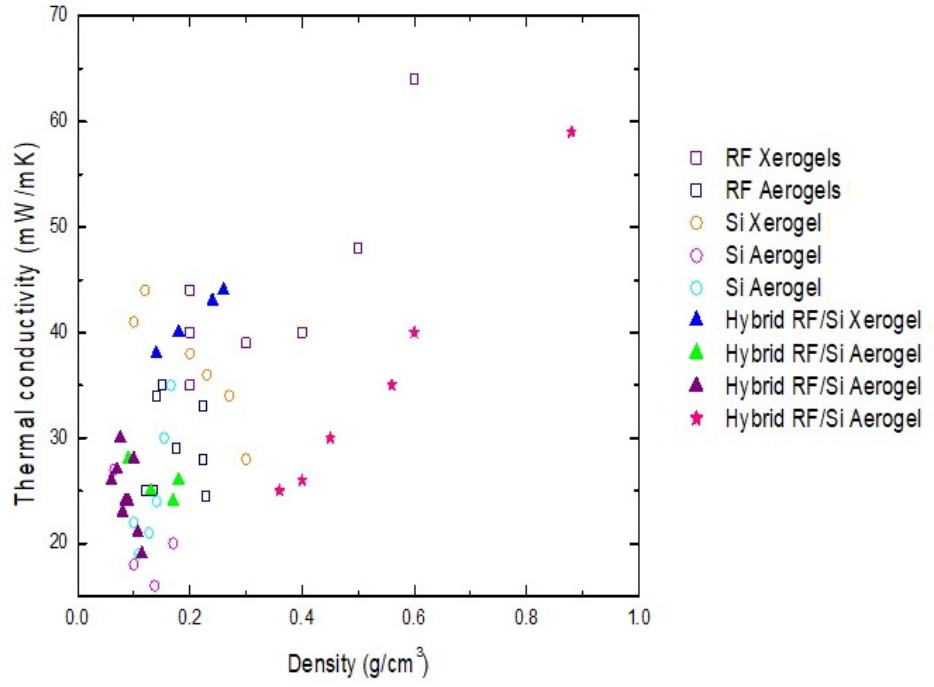
Figure 7. Comparison of insulation performance of the hybrid materials developed in this work, with hybrids, RF and Si gels from other references.